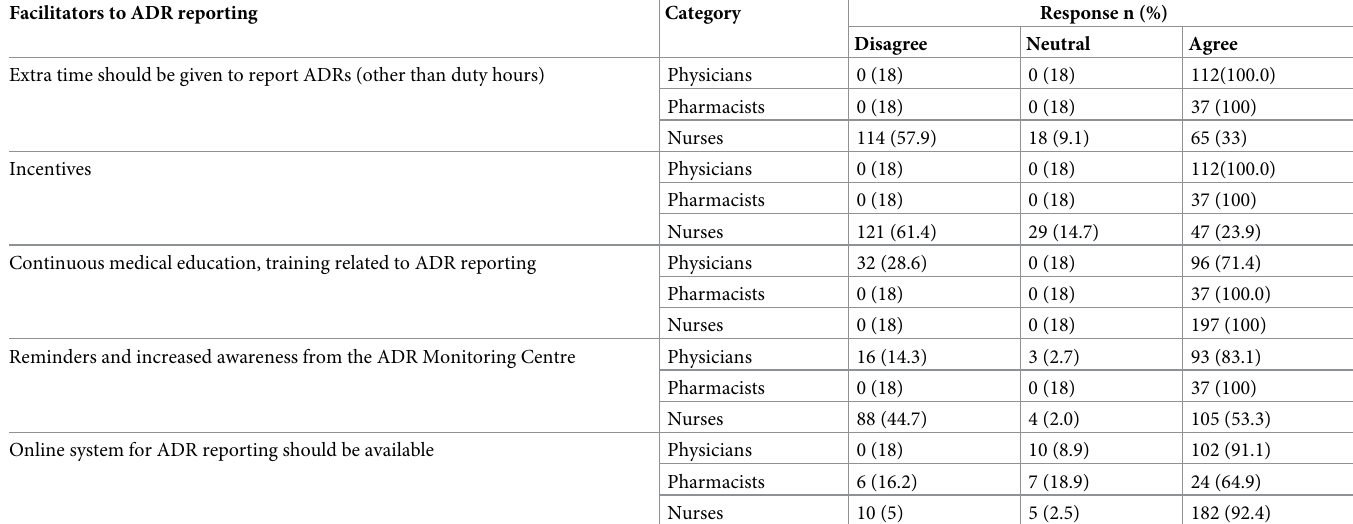
Table 3. Facilitators to ADR reporting by HCPs.